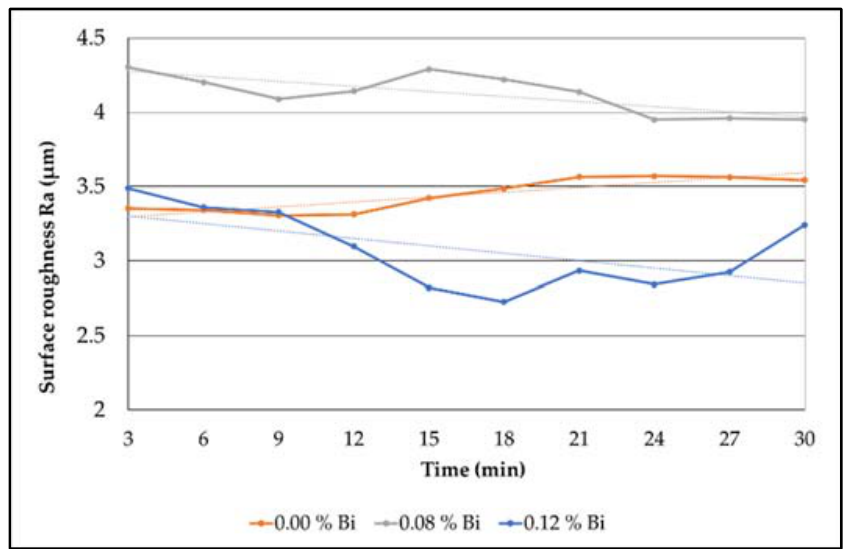
Figure 6. Dependence of the surface roughness of the material over time during the machinability tests of CMnCr steels with different Bi contents.